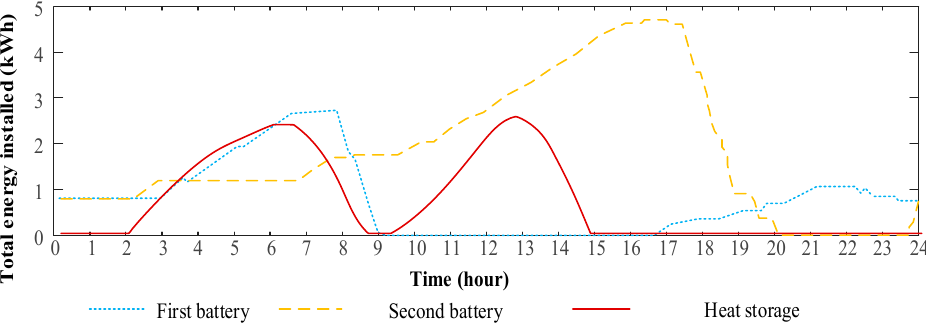
Figure 15. Energy Stored in hot water tank and batteries.